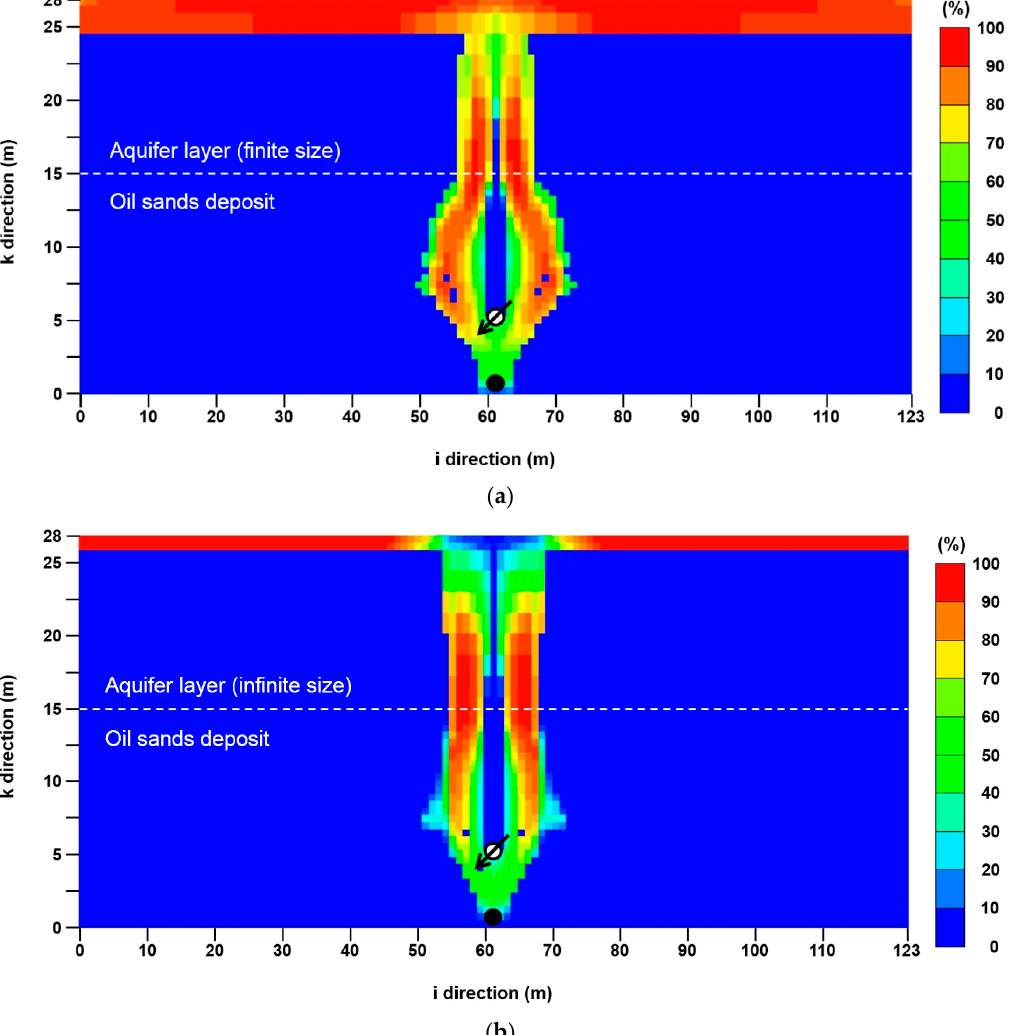
Figure 4. Nitrogen concentration to gas saturation at the end of production in the cases of: ( a ) the finite aquifer; and ( b ) the infinite aquifer.